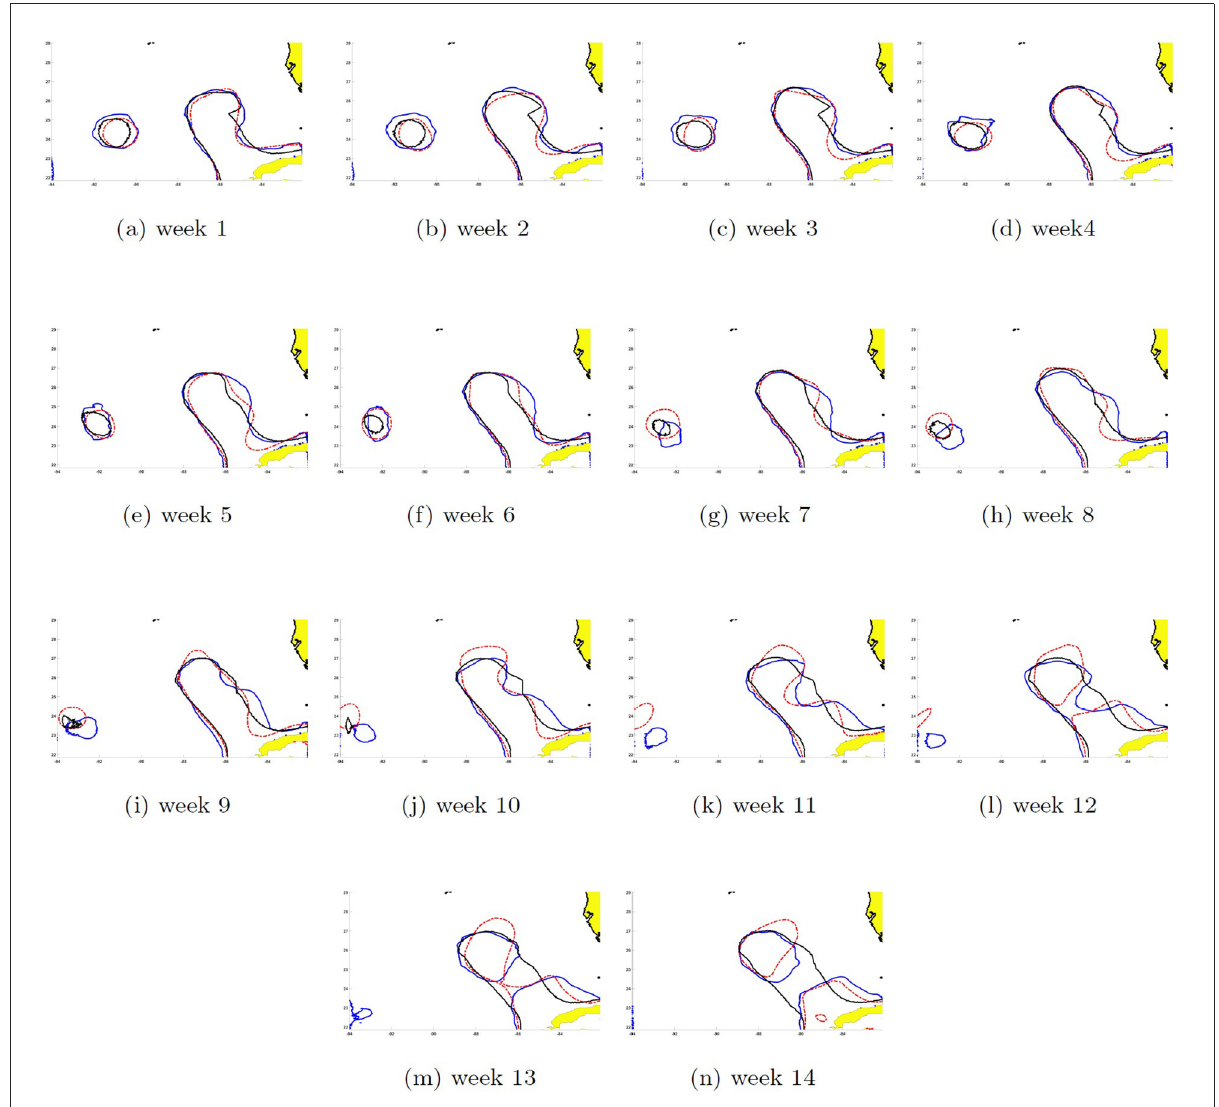
FIGURE15 Same as Figure 14 for eddy Darwin. The prediction was started the second week of October 2009. (a–n) Week 1–14.